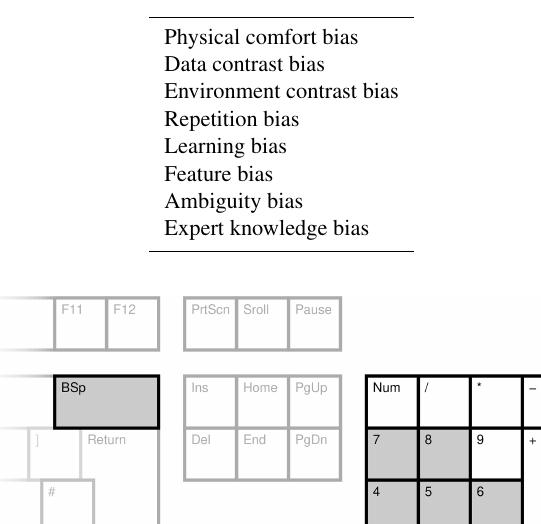
Table 2. A set of biases that may affect user classification.